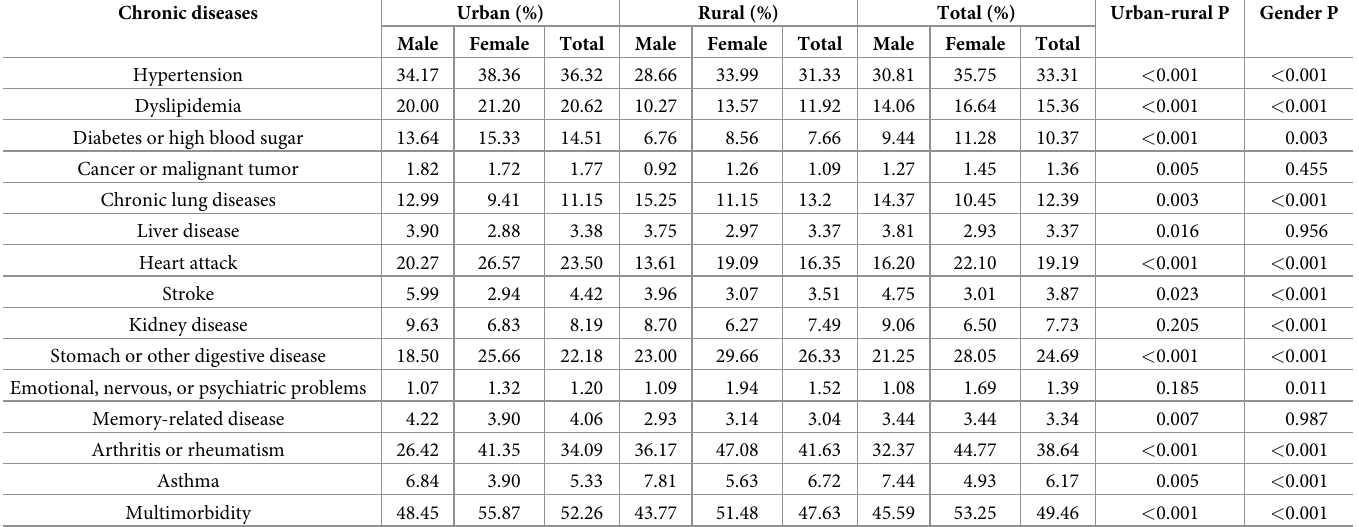
Table 1. The prevalence of chronic disease and